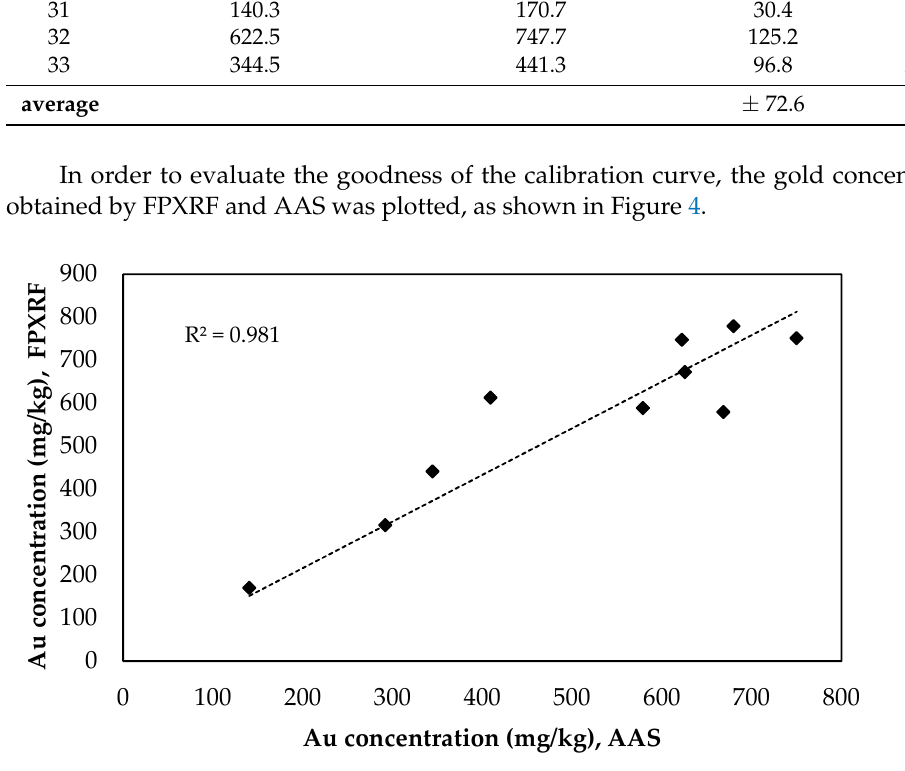
Figure 4. Regression of FPXRF and AAS concentration.